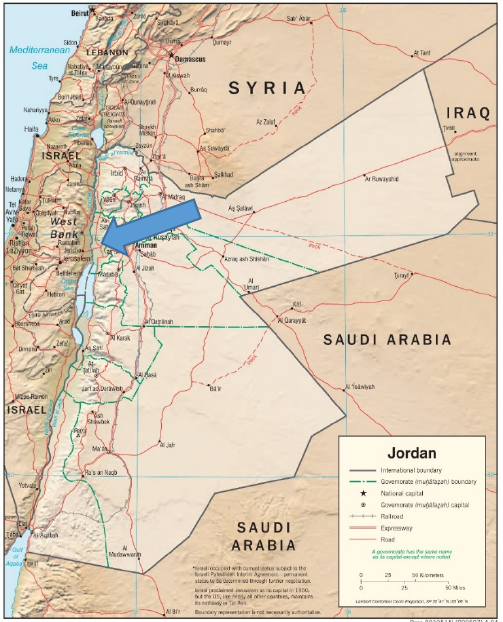
Figure 3. The specified location